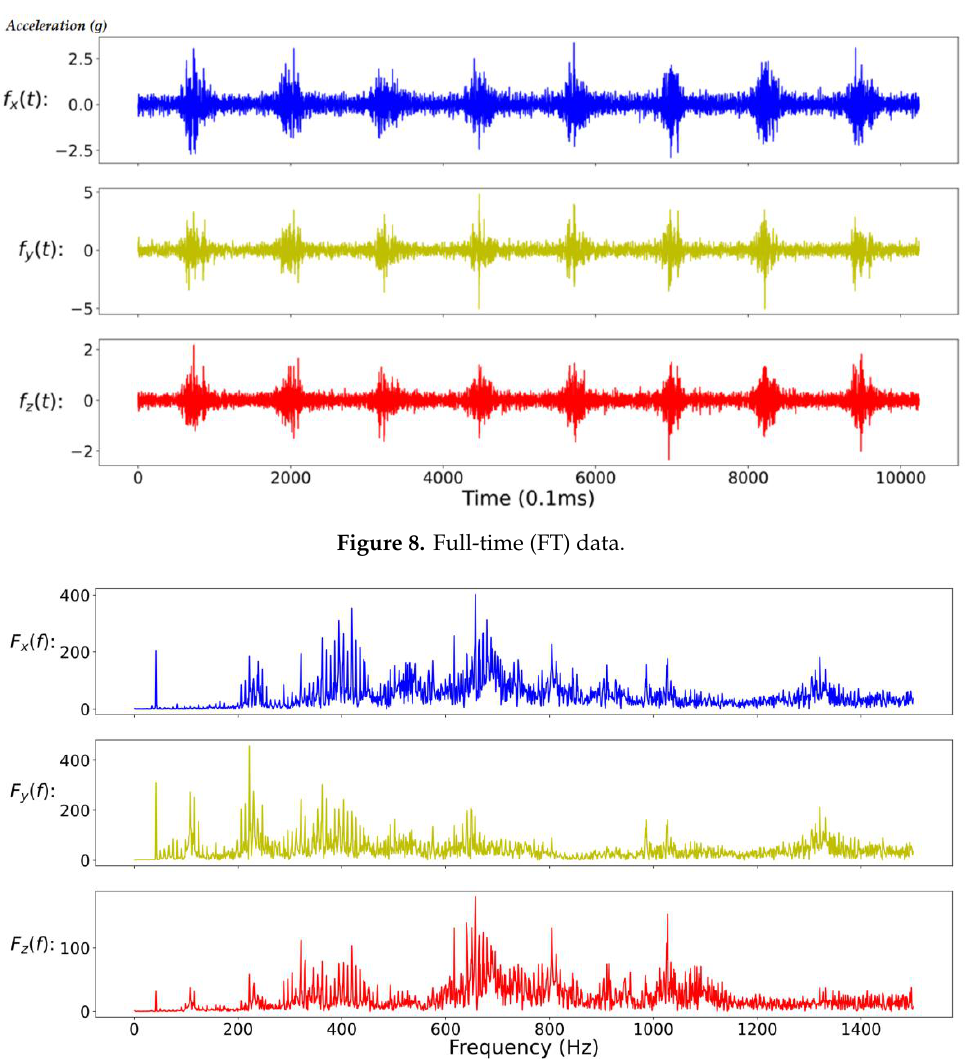
Figure 9. Low-frequency (LF) data.